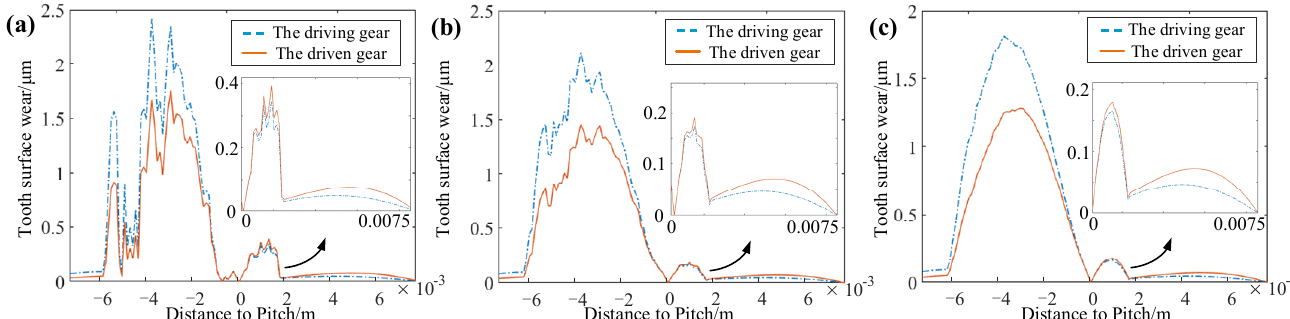
Figure 9. Initial tooth surface wear. ( a ) D = 1.43. ( b ) D = 1.5. ( c ) D = 1.6.